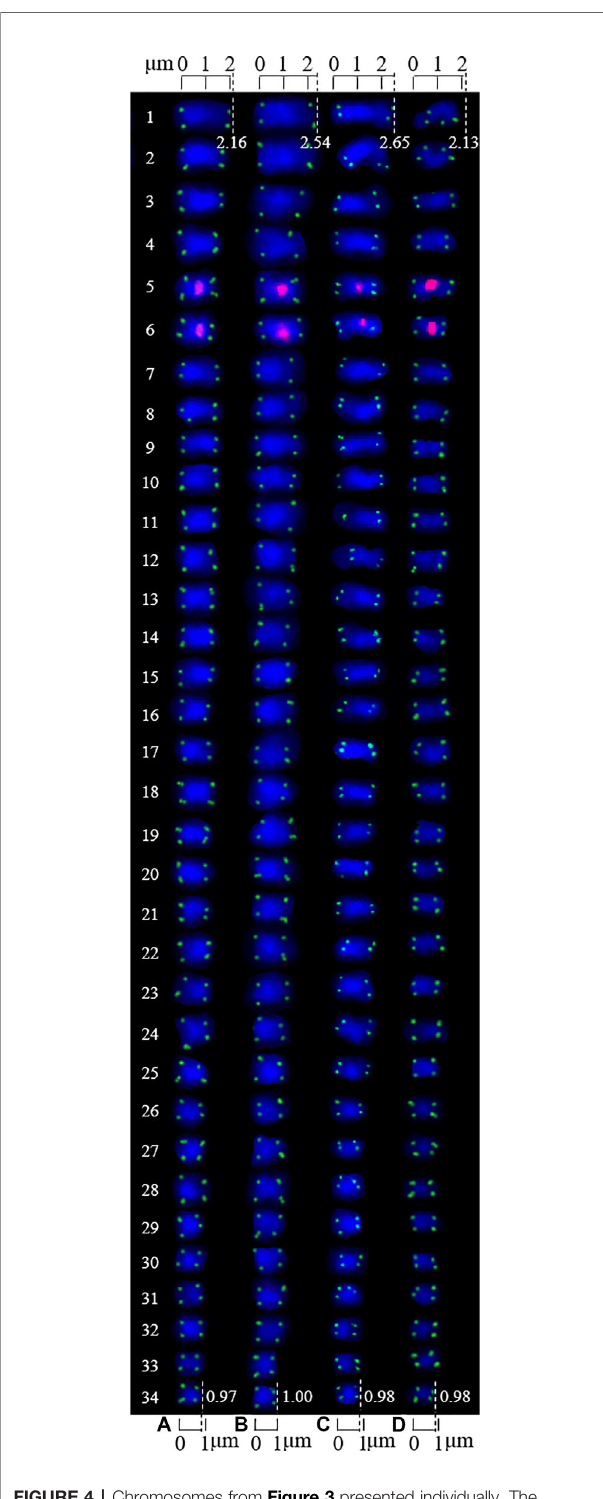
FIGURE 4 | Chromosomes from Figure 3 presented individually. The chromosomes were aligned by length from longest to shortest. The left number represents the chromosome number, while the top/bottom number represents the chromosome length. (A) Chuanzao 1, 2.16 – 0.97 m m; (B) Muzhilinhe, 2.54 – 1.00 m m; (C) Maerkang, 2.65 – 0.98 m m; (D) Yanyuanzao, 2.13 – 0.98 m